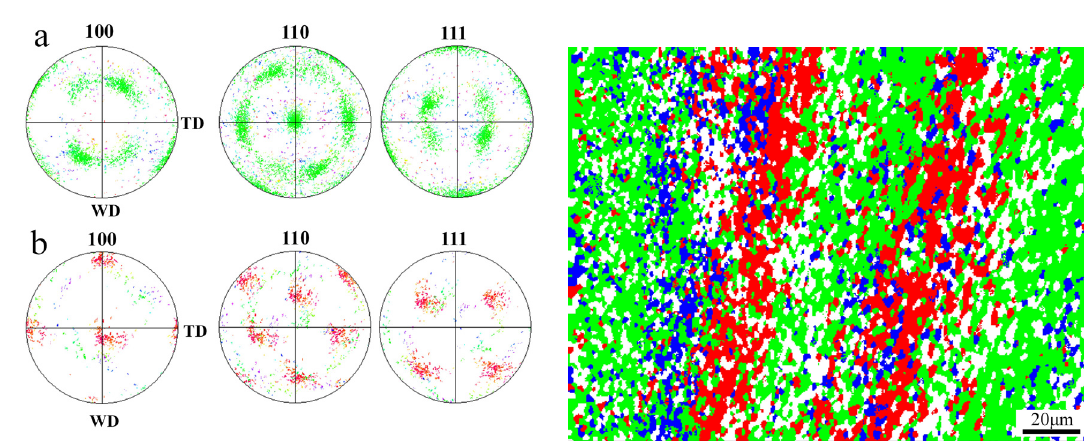
Figure 9. Pole figures for (a) region 3.1 and (b) region 3.2.